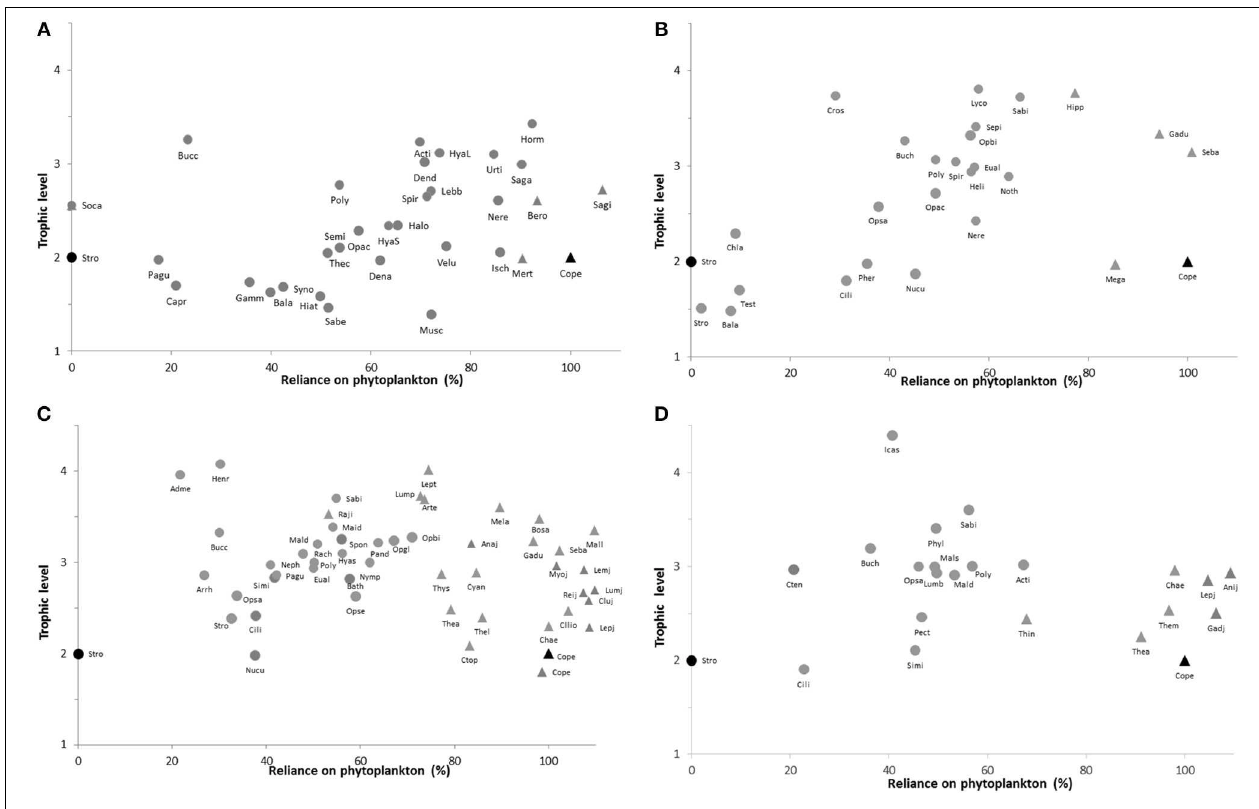
FIGURE 4 | Plots of trophic level vs. % reliance of the organism’s diet on phytoplankton for benthic (circles) and pelagic (triangles) taxa. Results are from mixing models with endpoints assuming Copepods feeding on 100% phytoplankton and Strongylocentrotus from